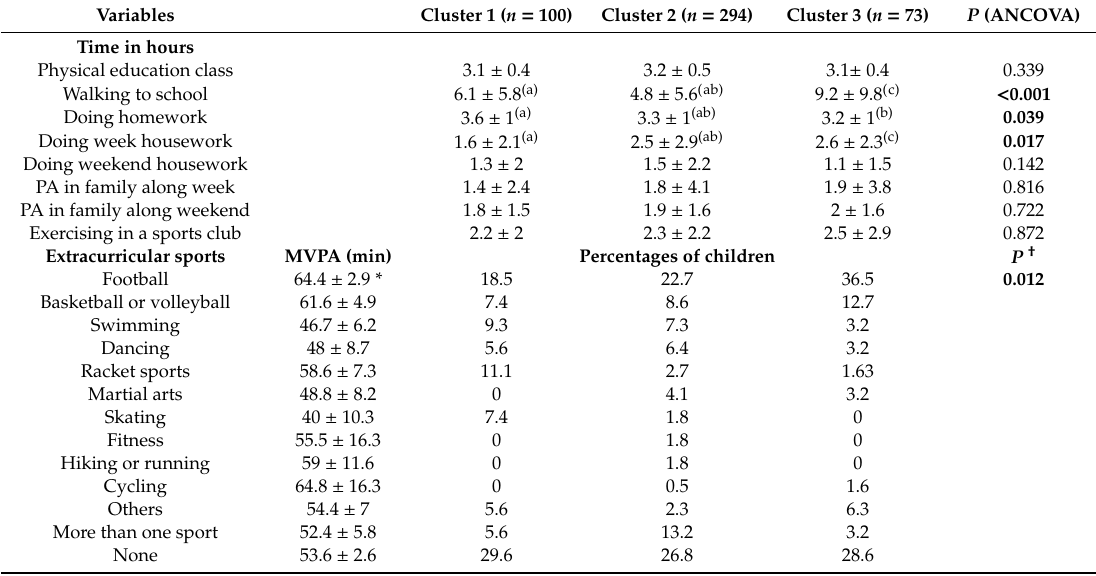
Table 2. Spent in lifestyle habits, and percentage of children practicing extracurricular sport activities with global time for of moderate to vigorous physical activity (MVPA) by